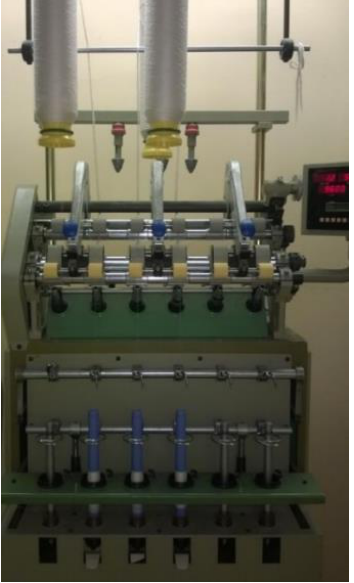
Figure 2. Laboratory Spinntester.